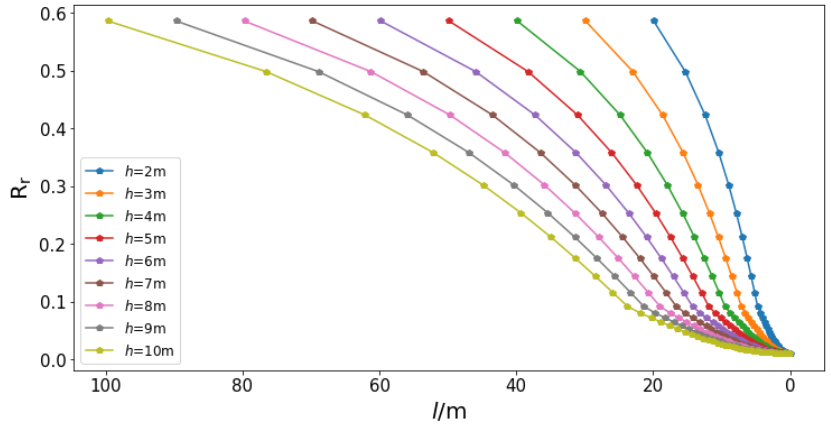
Figure 3. Relationship between water surface reflection and horizontal distance l with different heights